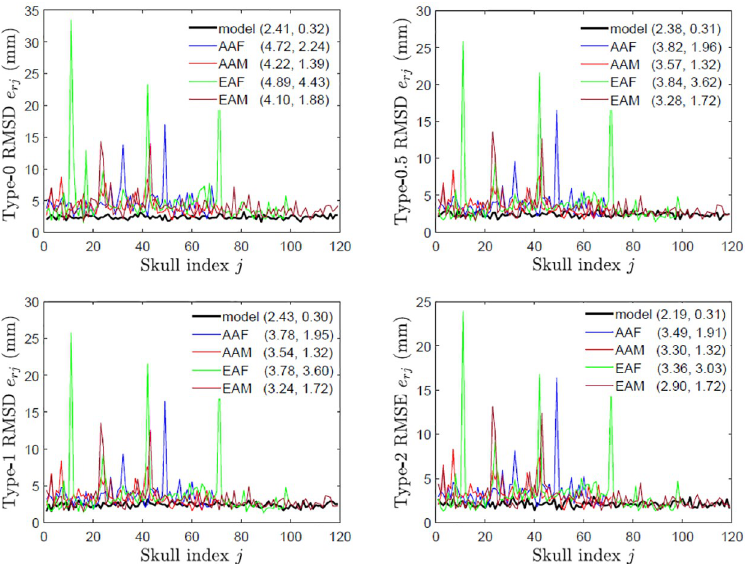
Fig 8. Skull asymmetry in different categories. RMSDs of asymmetry indices of the first 119 perturbed symmetric skulls (model) and original skulls with respect to different assessment types (0, 0.5, 1 and 2) and in different categories (AAF, AAM, EAF and EAM) are shown, where in brackets are the means and standard deviations of the RMSDs.